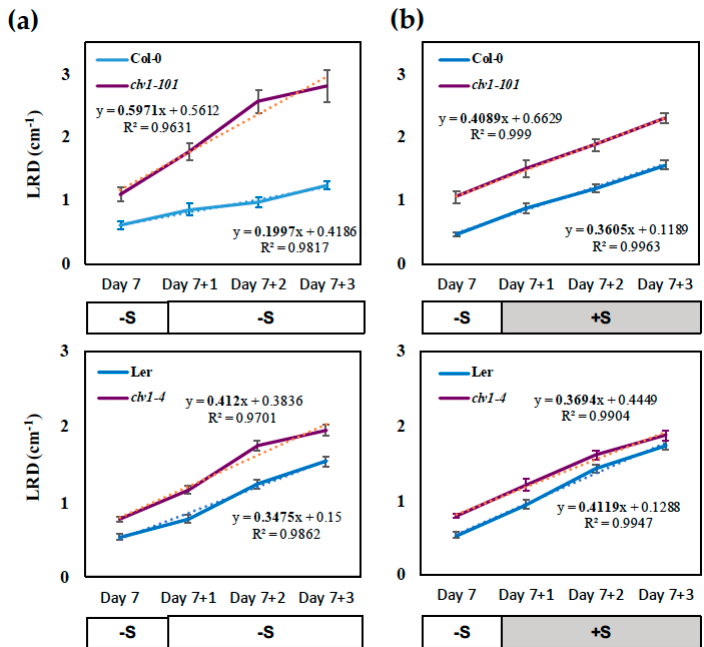
Figure 3. Effect of S supply on lateral root density (LRD). Wild-type (Col-0 and L er ) and clv1 mutant lines ( clv1-101 and clv1-4 ) were grown vertically on –S (15 μ M sulfate) medium for 7 days and then transferred to ( a ) –S medium or ( b ) +S medium to be grown subsequently for 3 days. LRD was calculated at each time point based on the number of emerged lateral roots (LRs) and the length of the primary root (PR) of one seedling. Values represent means (± SE) of 24 individual plants per treatment. The equations for the linear repression and the R-squared values are indicated on each graph.